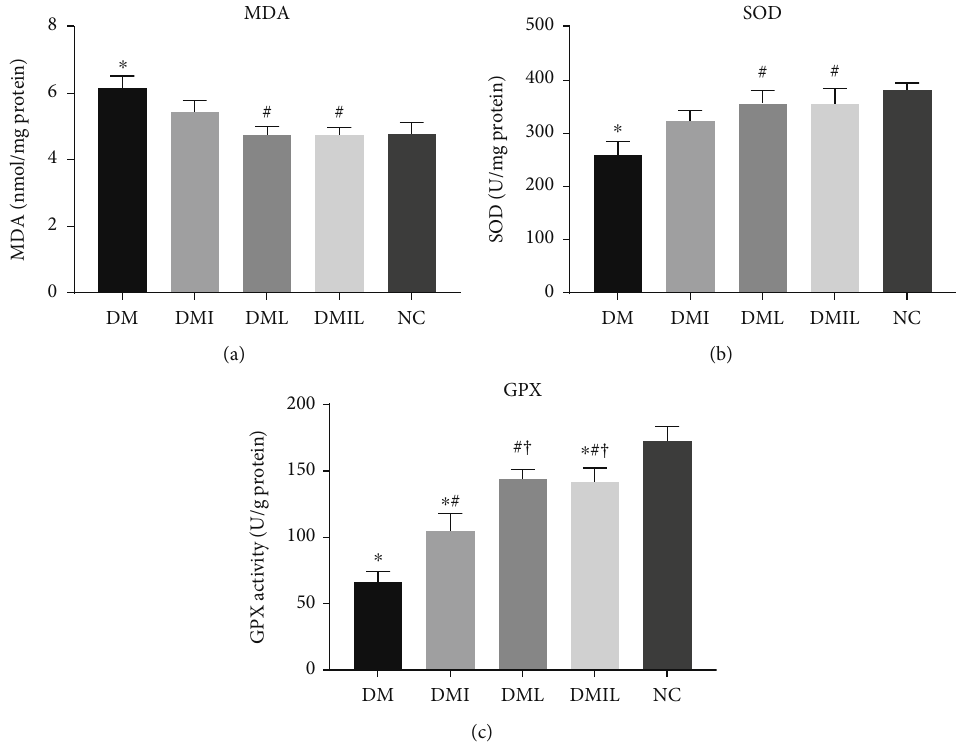
Figure 3: E ff ects of liraglutide on (a) MDA and hepatic oxidative stress markers (b) SOD and (c) GPX. Data are expressed as mean ± SD ( n = 4 /group); p < 0 : 05 was de fi ned as statistically signi fi cant. DM: saline-treated type 1 diabetes group; DMI: insulin treatment group; DML: liraglutide treatment group; DMIL: insulin+liraglutide treatment group; NC: normal glucose tolerance group; ∗ : compared to NC; #: compared to DM; † : compared to DMI; ‡ : compared to